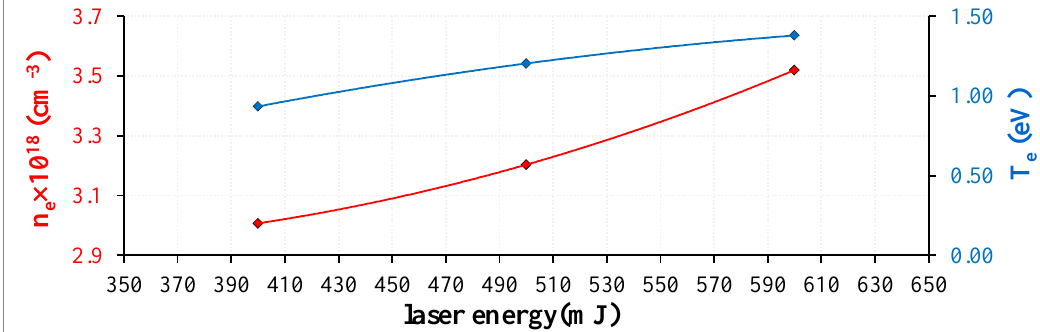
Figure 7: (Te) and (ne) against Laser Energy of the Indian costus target